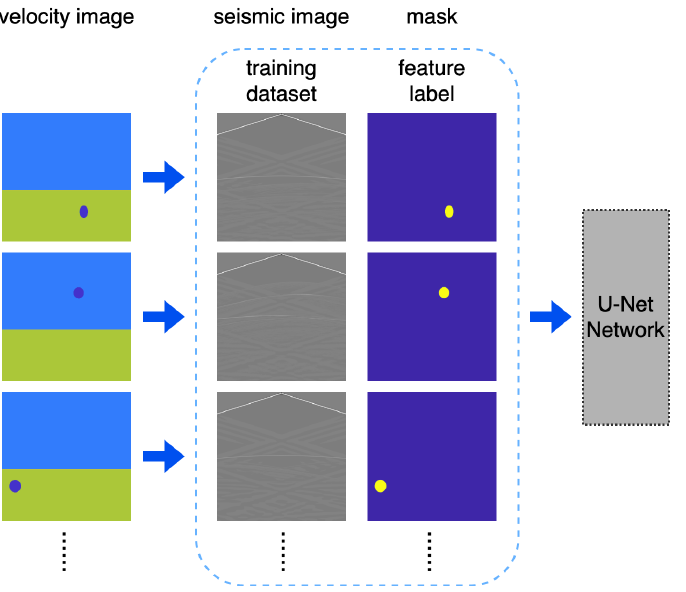
Figure 2. Training